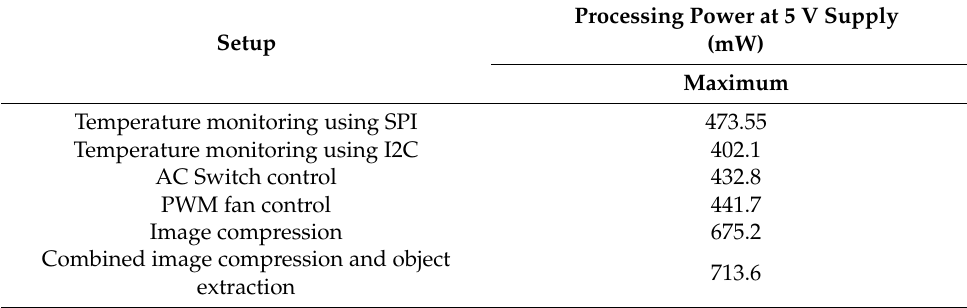
Table 6. Power consumption profile of the sensor node for different